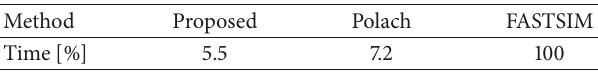
Table 6: Comparison of the computational times.